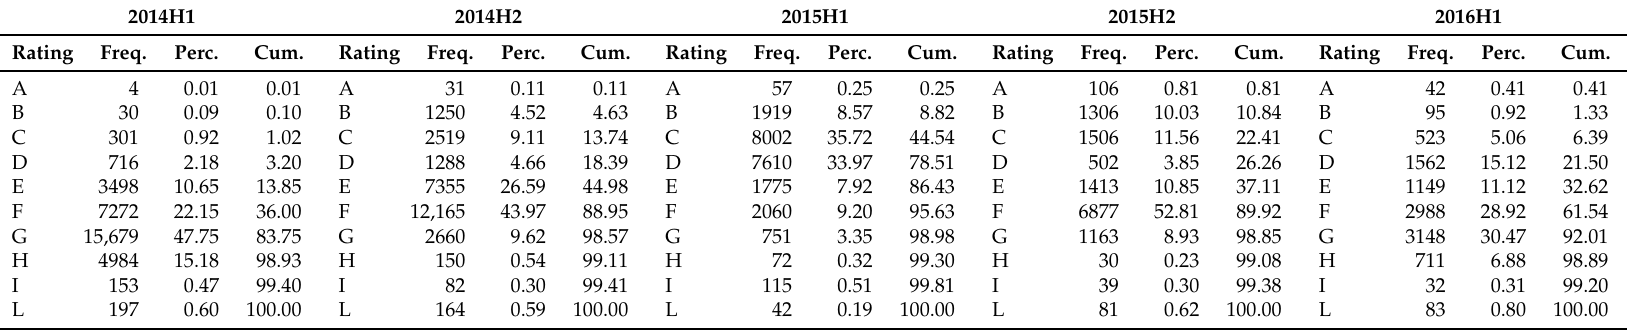
Table A1. The table shows the portfolio composition per rating across the pool cut-off dates. The distribution of counterparties is mainly concentrated in the intermediate rating